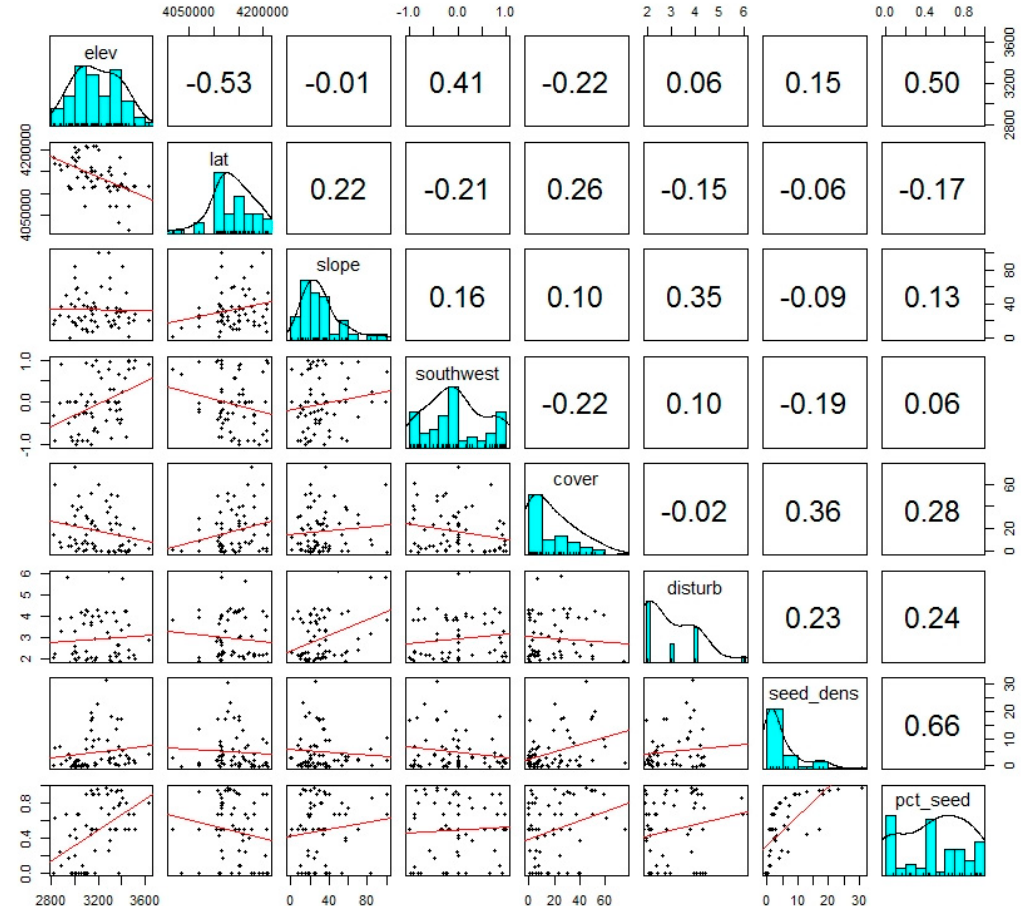
Figure 5. Scatterplot matrix for explanatory and response variables. elev = elevation, lat = latitude (m); southwest = southwestness, a measure of aspect; cover = main canopy cover of whitebark pine per 0.08 ha plot; disturb = categorical level of disturbance, where higher values represent greater severity and recency of disturbance; seed_dens = density of seedlings per ha; pct_seed = proportion of whitebark seedlings with respect to all conifer seedlings.